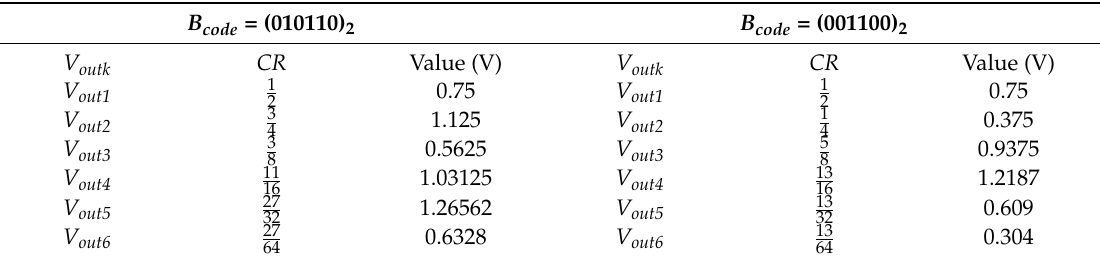
Table 2. Two different configuration codes with conversion ratios and generated output voltages.